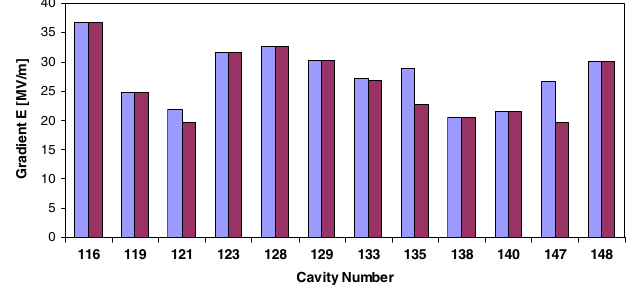
FIG. 6. (Color) Test results of cavities prepared for test accord- ing to the ‘‘BCP flash’’ treatments cycle. Blue: maximum acceleration gradient Eacc; Red: acceptance gradient for FLASH Eacpt.